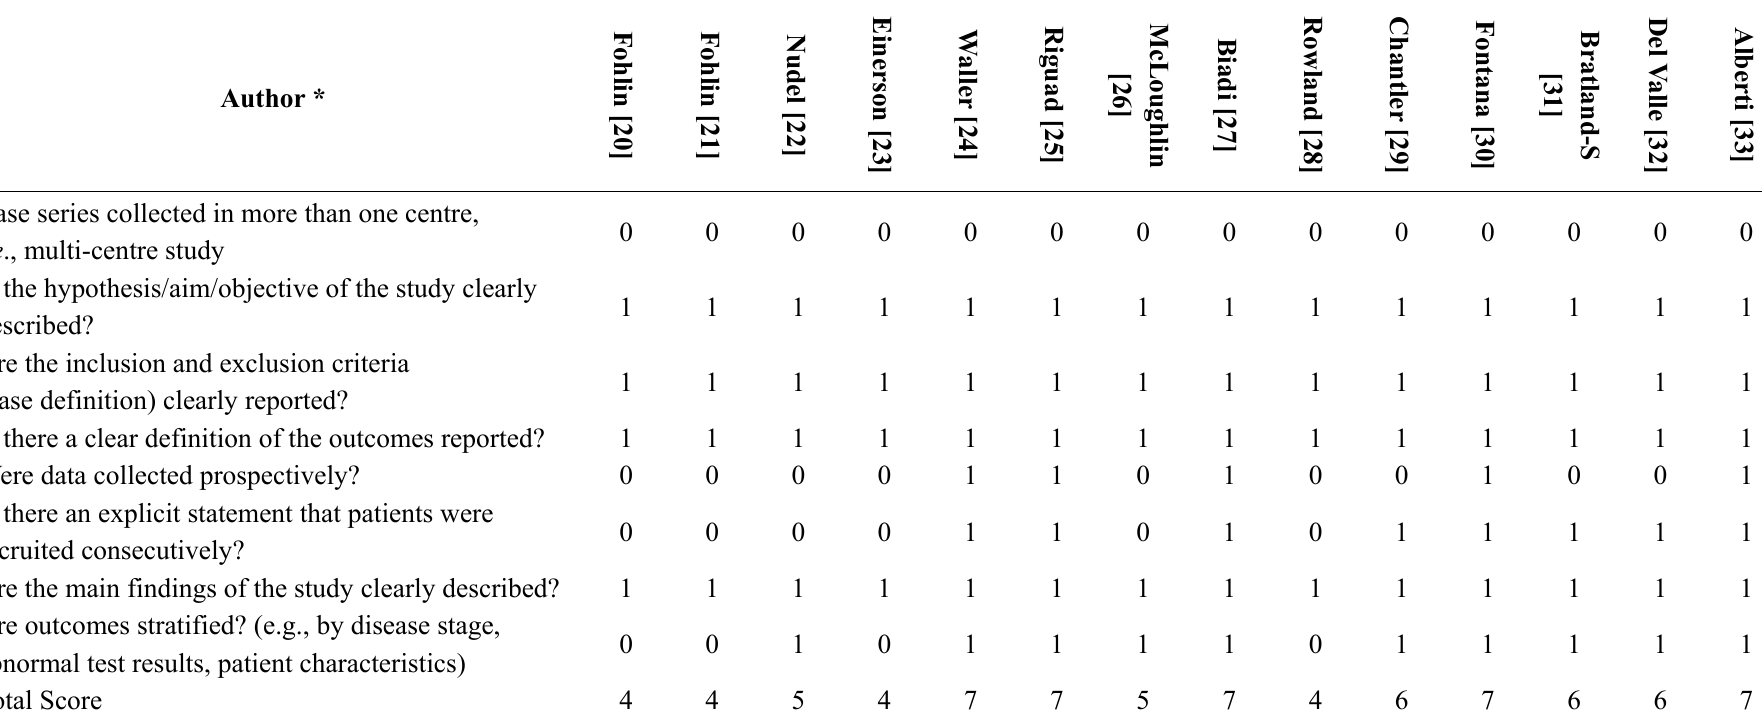
Table 3. Evaluation of methodological qualities of studies assessing physical fitness in eating